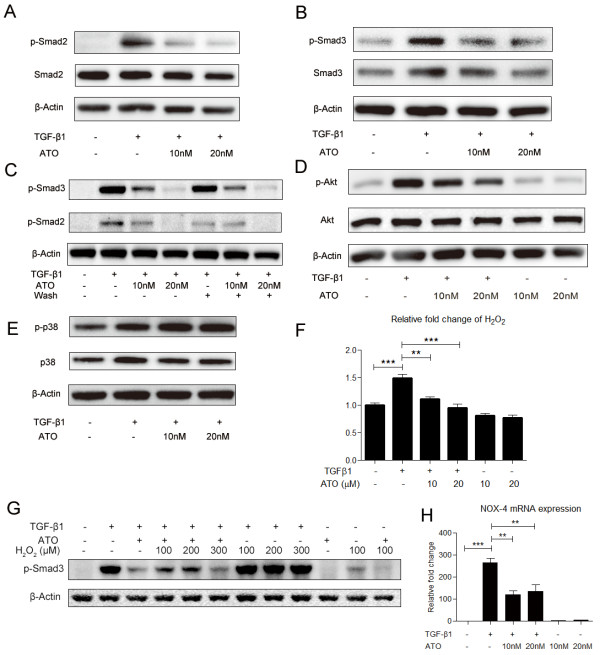
ATO inhibits Smad2/Smad3 and Akt phosphorylation but does not affect p38 phosphorylation. (A-B) NHLFs were pre-treated with ATO for 24 hrs. Then cells were treated with TGF-β1 (1 ng/ml) for 30 mins. TGF-β1 did not affect total Smad2 and Smad3 expression, but did increase their phosphorylation. TGF-β1 induced Smad2 and Smad3 phosphorylation were blocked by ATO. (C) NHLFs were pre-treated with ATO for 24 hrs, and then washed 5 times with PBS to remove ATO from the media. Thereafter cells were exposed to TGF-β1 (1 ng/ml) for 30 mins. The results indicate that the effects of ATO on TGF-β1 induced Smad2 and Smad3 phosphorylation are not due to disruption of the of the TGF-β1 ligand. (D) NHLFs were pre-treated with ATO for 24 hrs., and then treated with TGF-β1 (1 ng/ml) for 12 hrs. Akt phosphorylation was induced by TGF-β1 and this induction was diminished by ATO. (E) NHLFs were pre-treated with ATO for 24 hrs, then treated with TGF-β1 (1 ng/ml) for 30 mins. ATO increased TGF-β1 induced p38 phosphorylation. (F) TGF-β1 induces H2O2 in NHLFs. ATO at the indicated concentrations did not induce H2O2, but did diminish TGF-β1-induced H2O2 production. (G) NHLFs were pre-treated with ATO for 24 hrs, then treated with TGF-β1 (1 ng/ml) with or without H2O2 for 30 mins. Smad3 phosphorylation was up-regulated by H2O2.(H) TGF-β1 induced NOX-4 mRNA expression in NHLFs, whereas ATO at the indicated concentrations inhibited TGF-β1-induced NOX-4 mRNA expression. Western blot data represents consistent trend in three independent repeats with the best image quality. RT-PCR data represent results from three independent experiments with duplicate repeats. *P value < 0.05, **P value <0.01, ***P value < 0.001.